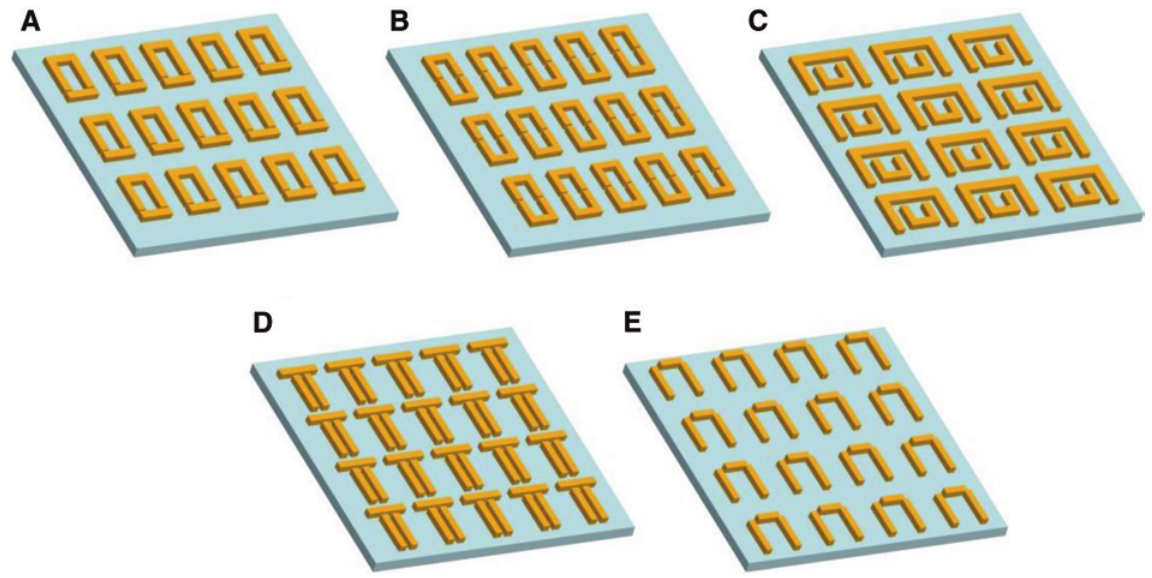
Figure 13: Various angular ring-shaped structures and Dolmen-type